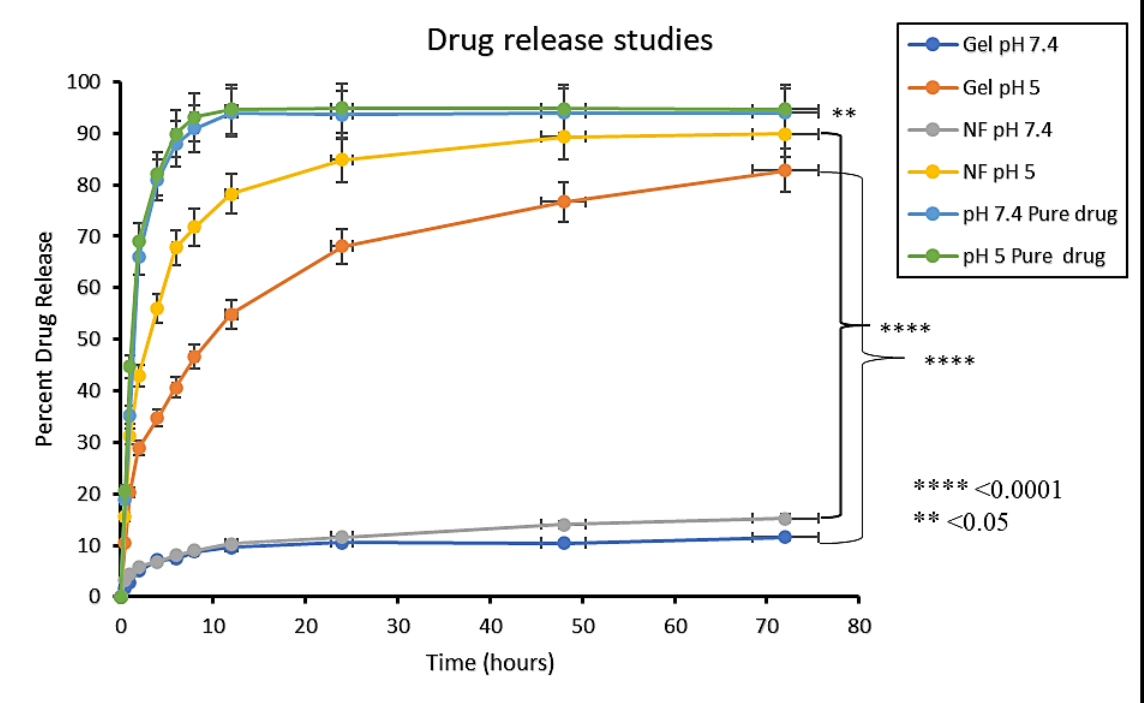
Figure 7. In vitro release study of MTX (Pure drug), MTX - NPs (NF) and MTX - NPs loaded hydrogel (gel) in phosphate buffers at various pH, i.e., 5 and 7.4, **** p - value ≤ 0.0001, ** p - value ≤ 0.05 .